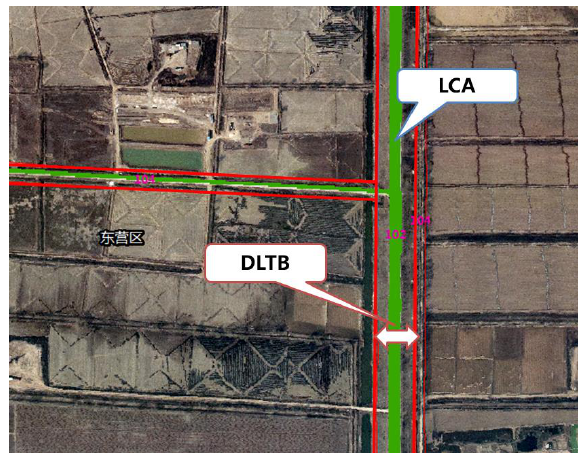
Figure 5. Inconsistent definition of road range in land use and land cover